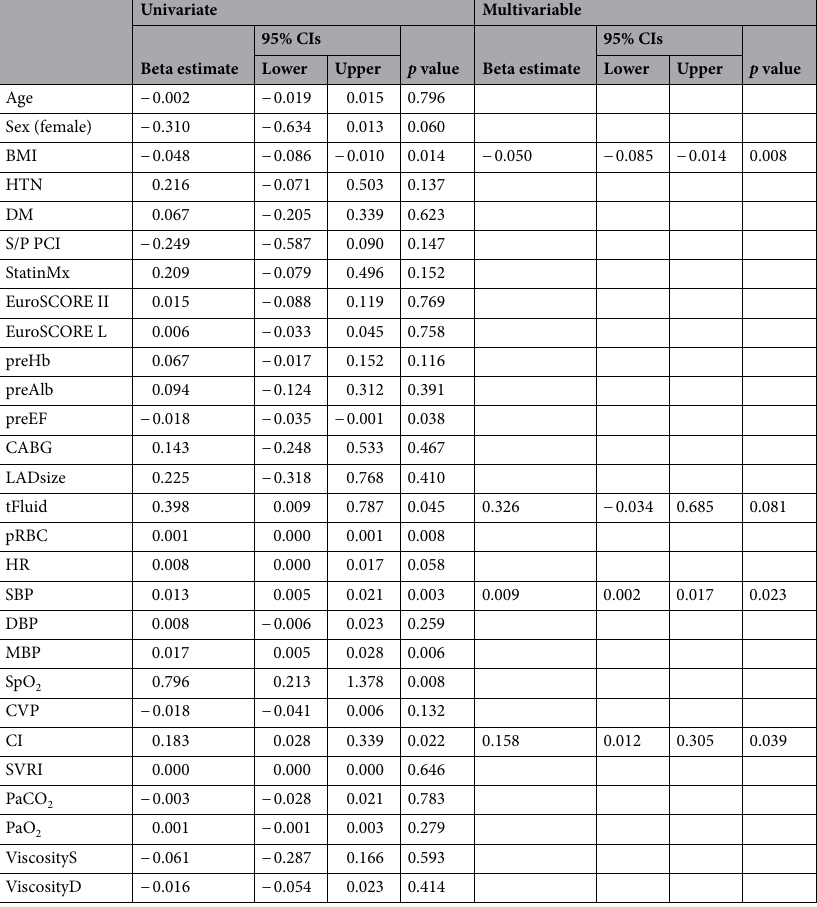
Table 4. Univariate and multivariate linear regression analysis of factors associated with the MFR of TTFM. TTFM transit-time flow measurement, MFR mean flow rate, CIs confidence intervals, BMI body mass